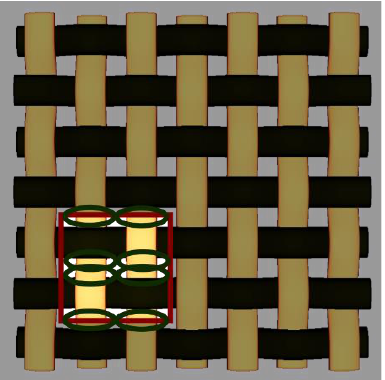
Figure 5. The RUC of satin 2/1/1 relative to a 7 × 7 yarns reference area. The number of undulations is defined as the number of times the warp yarns crimp when exchanging position with fill yarns, relative to the middle plane. For example, in the case of satin 2/1/1, the undulation count for the warp is considered to be 8 for the RUC zone ( 𝑈𝐶 𝑅𝑈𝐶 ) and 98 for the whole reference area. To quantify the undulation density, the current undulation count is compared to a reference one. This reference is the count of the most-crimpy woven fabric possible, namely, the plain wave. The undulations density ( 𝜌 𝑢𝑛𝑑 ) is the undulation count for the RUC in relation with the plain wave count for the same RUC area ( 𝑈𝐶 𝑅𝑈𝐶2/1/1 ). In this particular case of a plain weave, 𝜌 𝑢𝑛𝑑2/1/1 = 100%; see Equation (3).